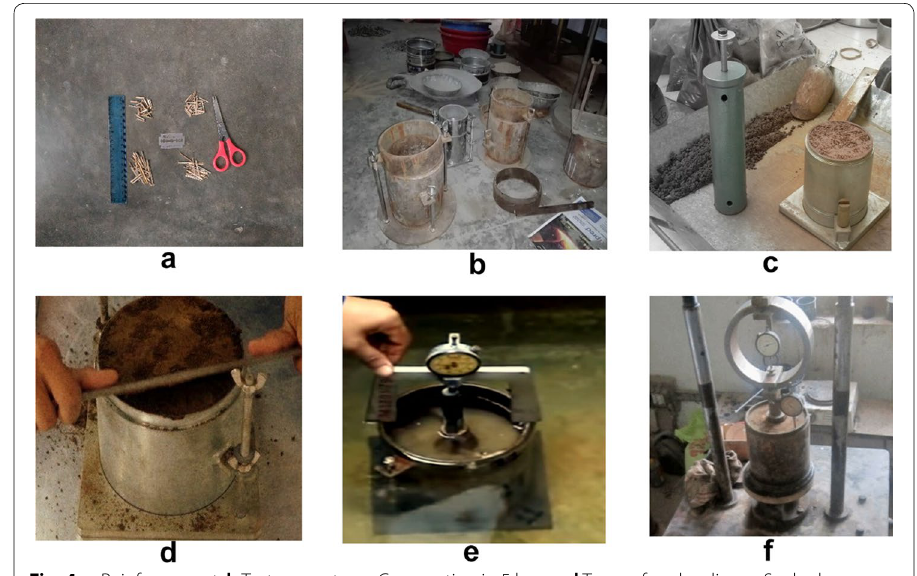
Fig. 4 a Reinforcement. b Test apparatus. c Compaction in 5 layers. d Top surface leveling. e Soaked condition. f Loading frame